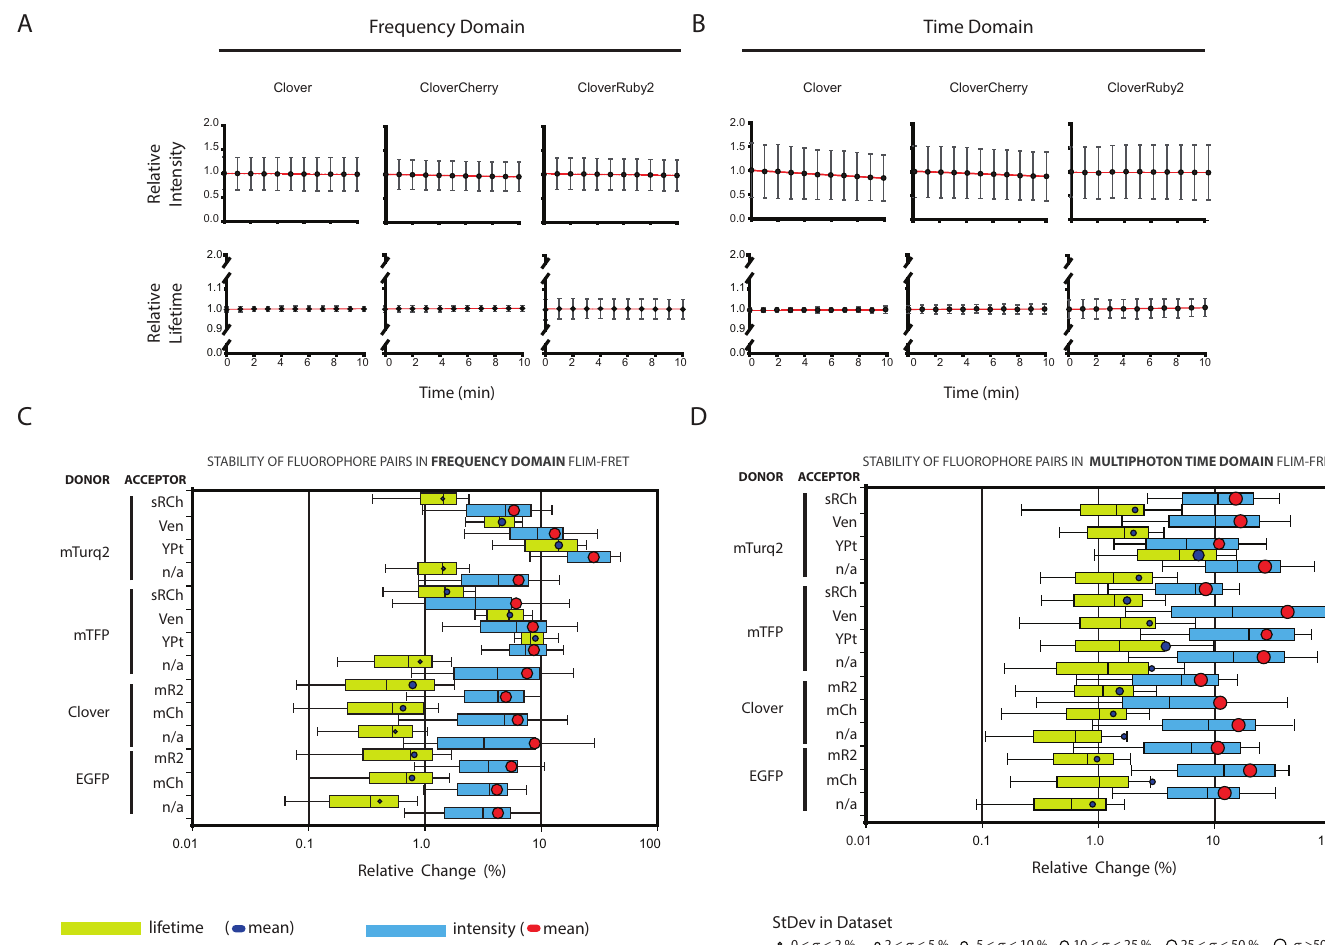
Fig 5. Evaluating stability and variability in fluorescence intensity and fluorescence lifetime. A. Example frequency domain time course intensity and lifetime data (in this case, for the green donor Clv). In both cases error bars represent the standard deviation in the normalised intensity and lifetime measurements (each individual cells time course normalised to the mean t = 0 value for that experimental day.) Full data set available in S4 Fig. B . Example multiphoton time domain time course intensity and lifetime data (in this case, for the green donor Clv). In both cases error bars represent the standard deviation in the normalised intensity and lifetime measurements (each individual cells time course normalised to the mean t = 0 value for that experimental day) Full data set available in S5C Fig . Summary of temporal stability and inter-sample variability in frequency domain data. Box plots represent the distribution of the change ( i . e .the difference between t = 0 and t = 10 values) in each measurement (fluorescence lifetime = lime green box with blue mean symbol; fluorescence intensity = turquoise box with red mean symbol) over the timecourse, showing the range of the 10 th to 90th percentiles (whiskers) and the 25 th to 75 th percentiles (boxes), for all the data sets contributing to the timecourse charts shown in S5 Fig. The median change is marked by an internal black line, the mean change by the centre of the circular points. The size of these circular data points is proportional to the scale of the error in the total data set, with smaller markets indicating a smaller standard deviation in the data. D. Summary of temporal stability and inter-sample variability in multiphoton time domain data. Box plots represent the distribution of the change ( i . e .the difference between t = 0 and t = 10 values) in each measurement (fluorescence lifetime = lime green box with blue mean symbol; fluorescence intensity = turquoise box with red mean symbol) over the timecourse, showing the range of the 10 th to 90th percentiles (whiskers) and the 25 th to 75 th percentiles (boxes), for all the data sets contributing to the timecourse charts shown in S6 Fig. The median change is marked by an internal black line, the mean change by the centre of the circular points. The size of these circular data points is proportional to the scale of the error in the total data set, with smaller markets indicating a smaller standard deviation in the